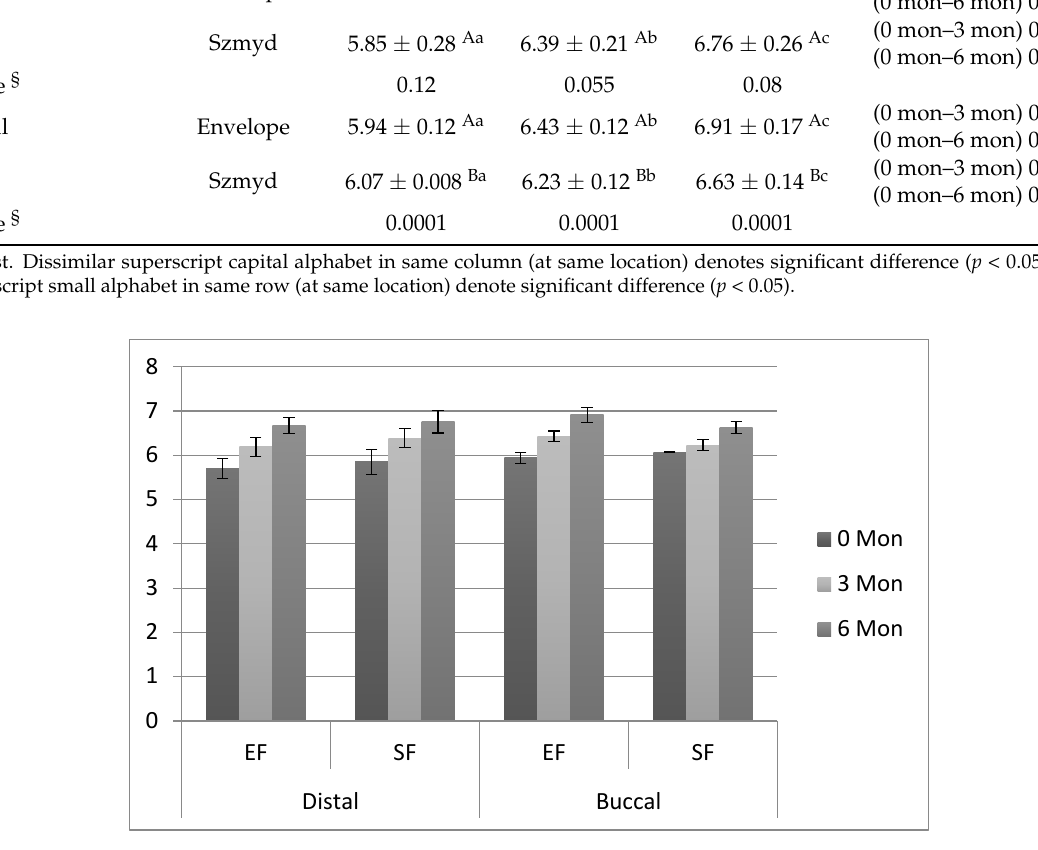
Table 5. Comparison of clinical attachment loss (mm) around second molars among study groups.